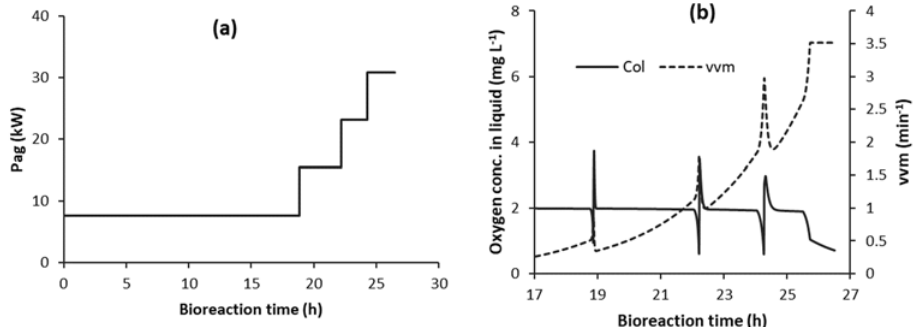
Figure 9. E ff ect of C OL_FLD = 0.5 mg L − 1 on control strategy C1 F -5 (with automatic detection of Figure 9. Effect of C OL_FLD = 0.5 mg L − 1 on control strategy C1 F ‐ 5 (with automatic detection of flooding;